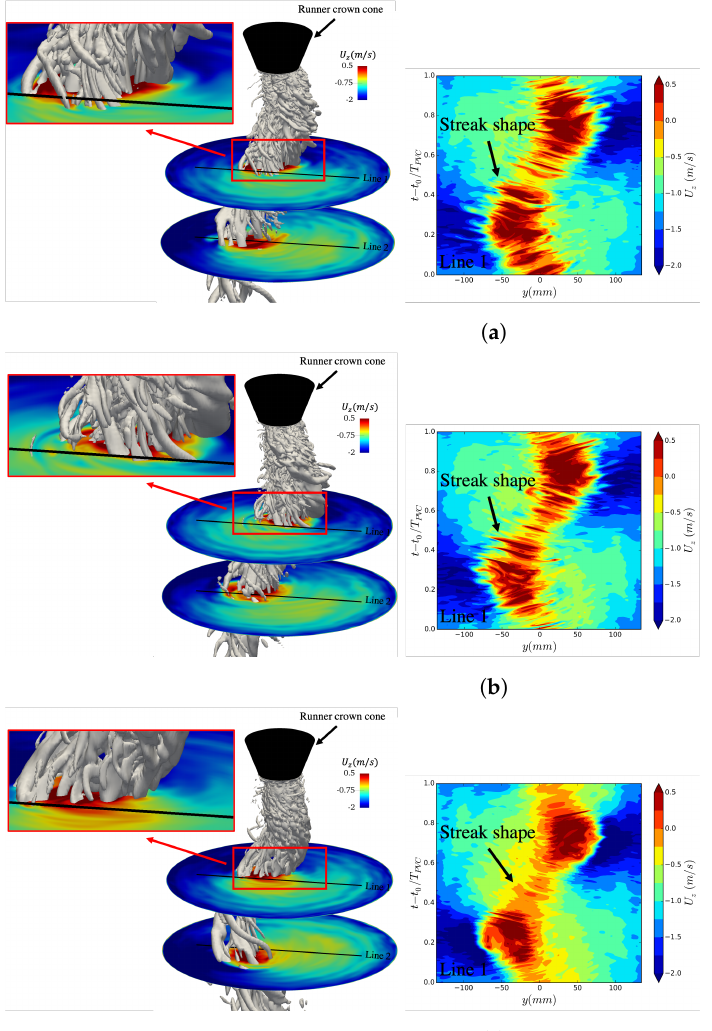
Figure 14. RVR, visualized by Q = 5000 s − 2 (left), and its effects on the velocity at Line 1 during one cycle (right) for different cavitation numbers, ( a ) σ = 0.07, ( b ) σ = 0.06, ( c ) σ =